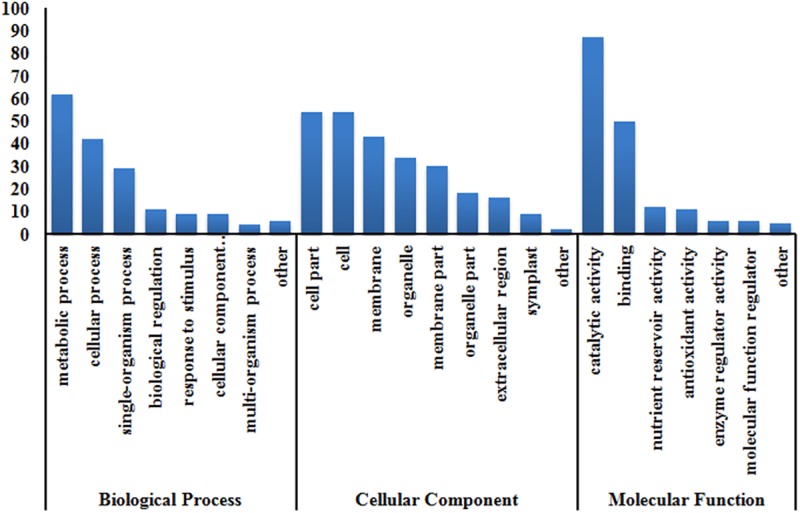
GO classification of the identified glycoproteins in terms of biological process, cellular component and molecular function.